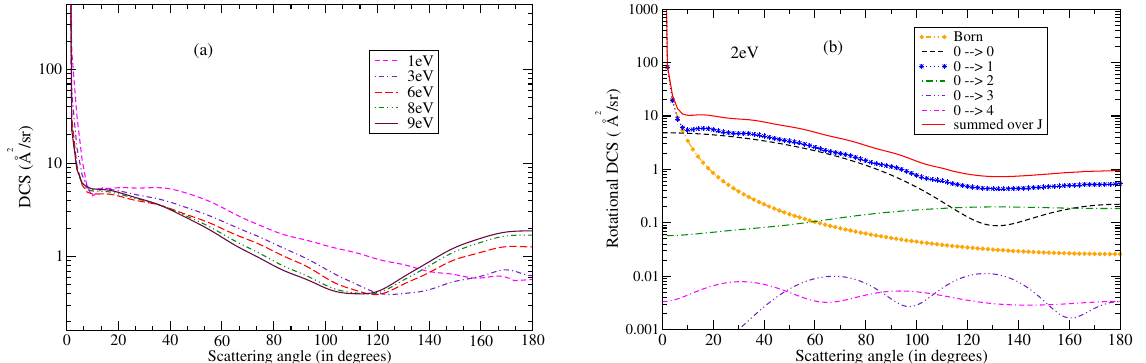
Figure 7. ( a ) Rotationally summed DCS at different incident energies obtained using 12-states CC model. 1 eV; dashed curve, 3 eV; dotted dashed curve, big dashed curve; 6 eV and 8 eV; double dotted dashed curve, 9 eV; line curve ( b ) Rotationally resolved and summed DCS at 2 eV: 0 → 0 transition, dashed curve; 0 → 1 transition, dotted curve with star; 0 → 2 transition, dotted dashed curve; 0 → 3 transition, double dotted dashed curve; 0 → 4 transition, dashed dotted curve; circles, summed (0 → J ); circle with dotted line curve, Born approximation;